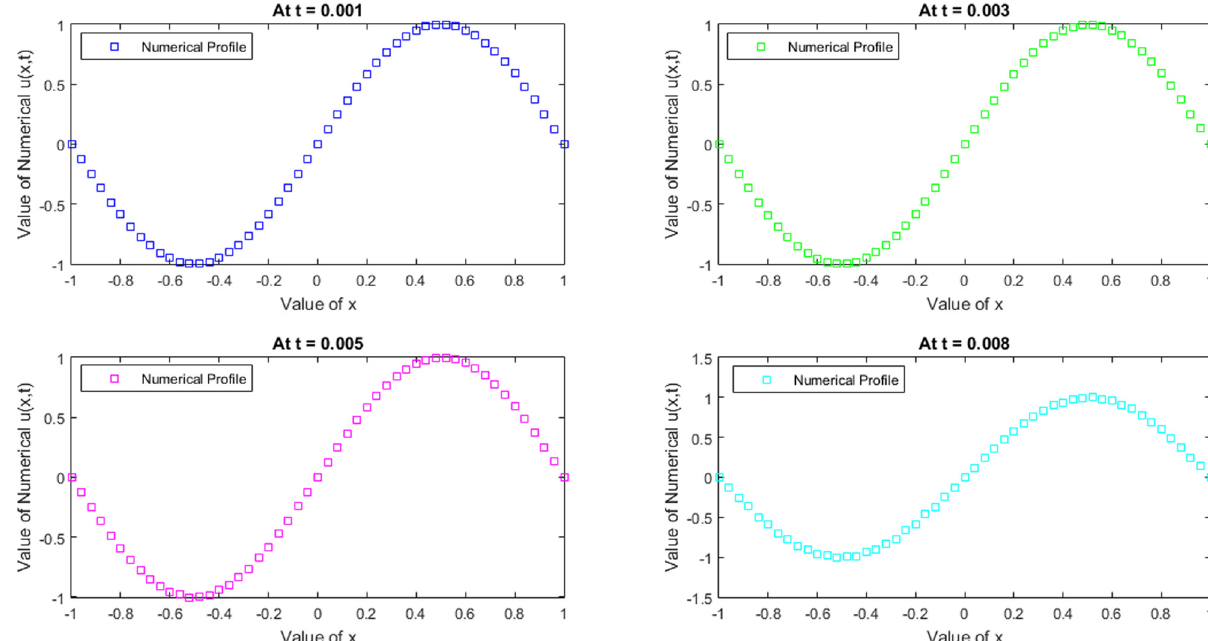
Figure 9: Numerical solutions for = N 101 , = t Δ 0.0001 , = α 1 , and = ν 0.01 .